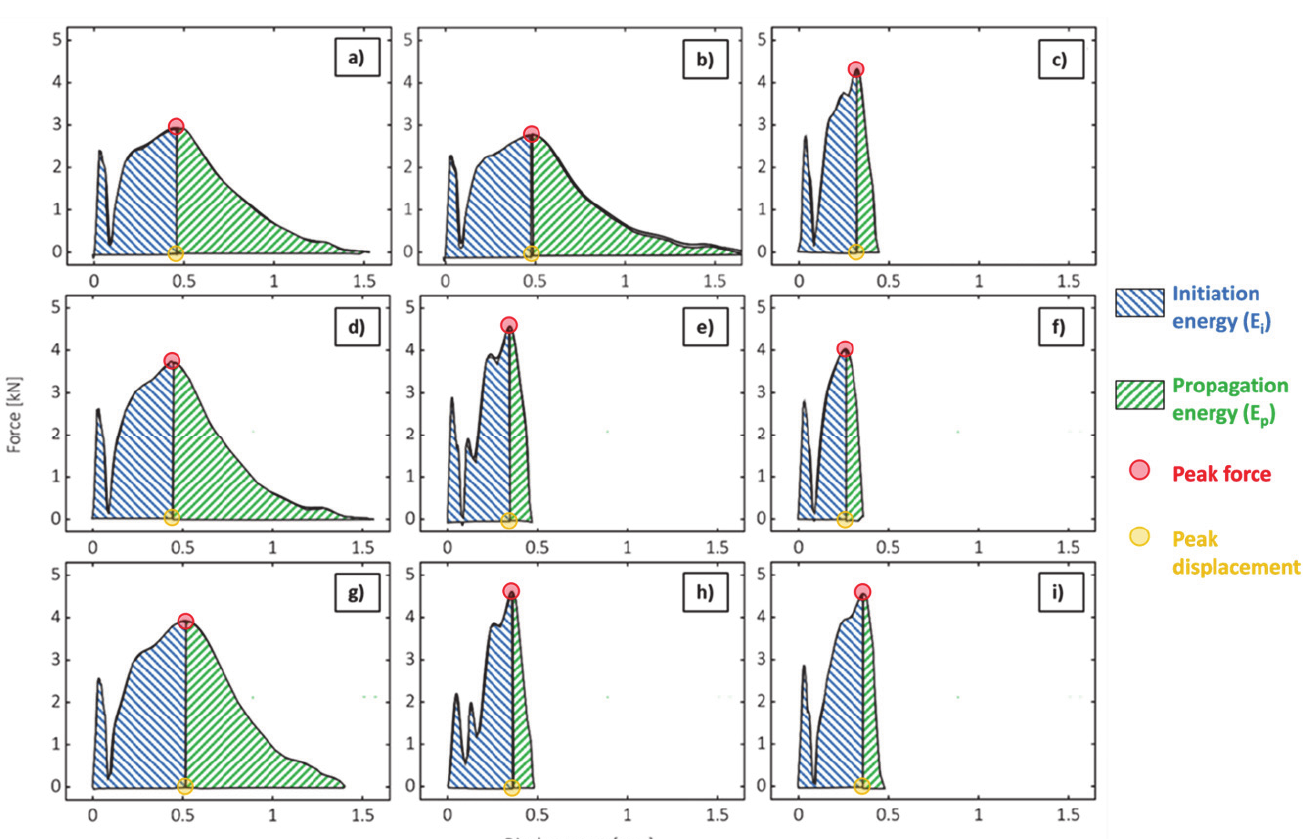
Figure 6: A single force-displacement curve for gravity cast specimen in (a) as-cast, (b) annealed, (c) T6, (d) HIP 50 , (e) HIP 50 +T6, (f) HPT6 50 , (g) HIP 150 , (h) HIP 150 +T6, (i) HPT6 150 conditions.